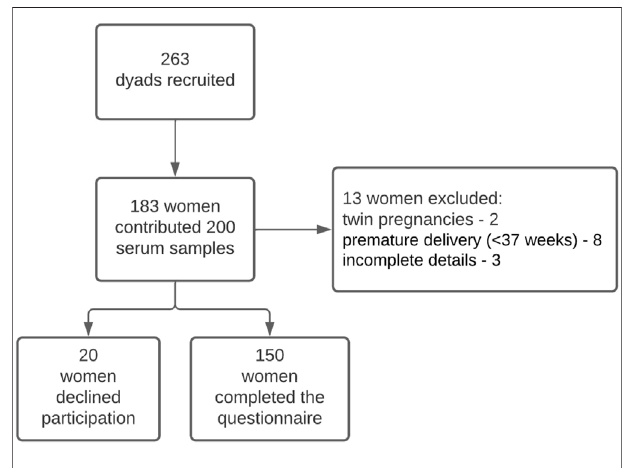
FIGURE 1 | Flowchart of study population.